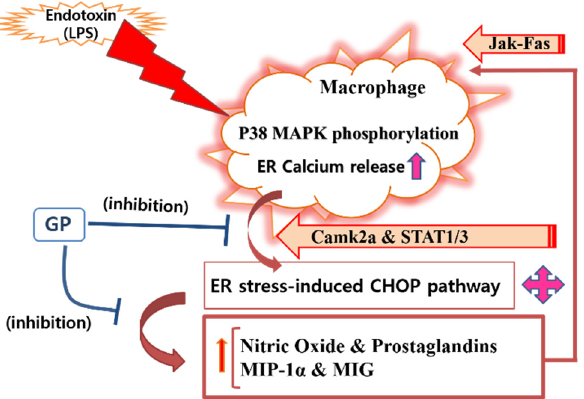
Figure 5. A combination extract of Gardeniae Fructus and Perillae Folium (GP) inhibits hyper-inflammatory reactions in LPS-activated RAW 264.7 via ER stress-induced CHOP pathway.